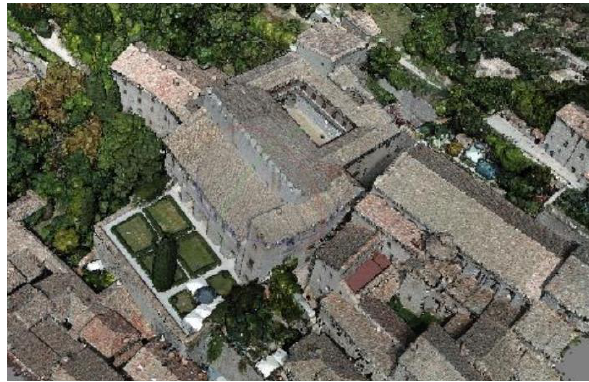
Figure 5. MMS point cloud. The paths are shown by dark